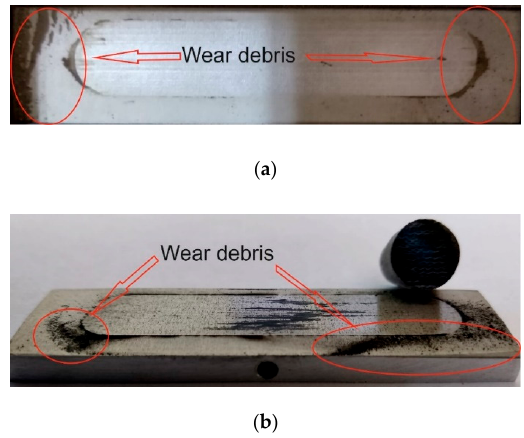
Materials 2020 , 13 , x FOR PEER REVIEW Figure 14. Al 2 O 3 coating with visible wear debris from a pin of PF + jute.